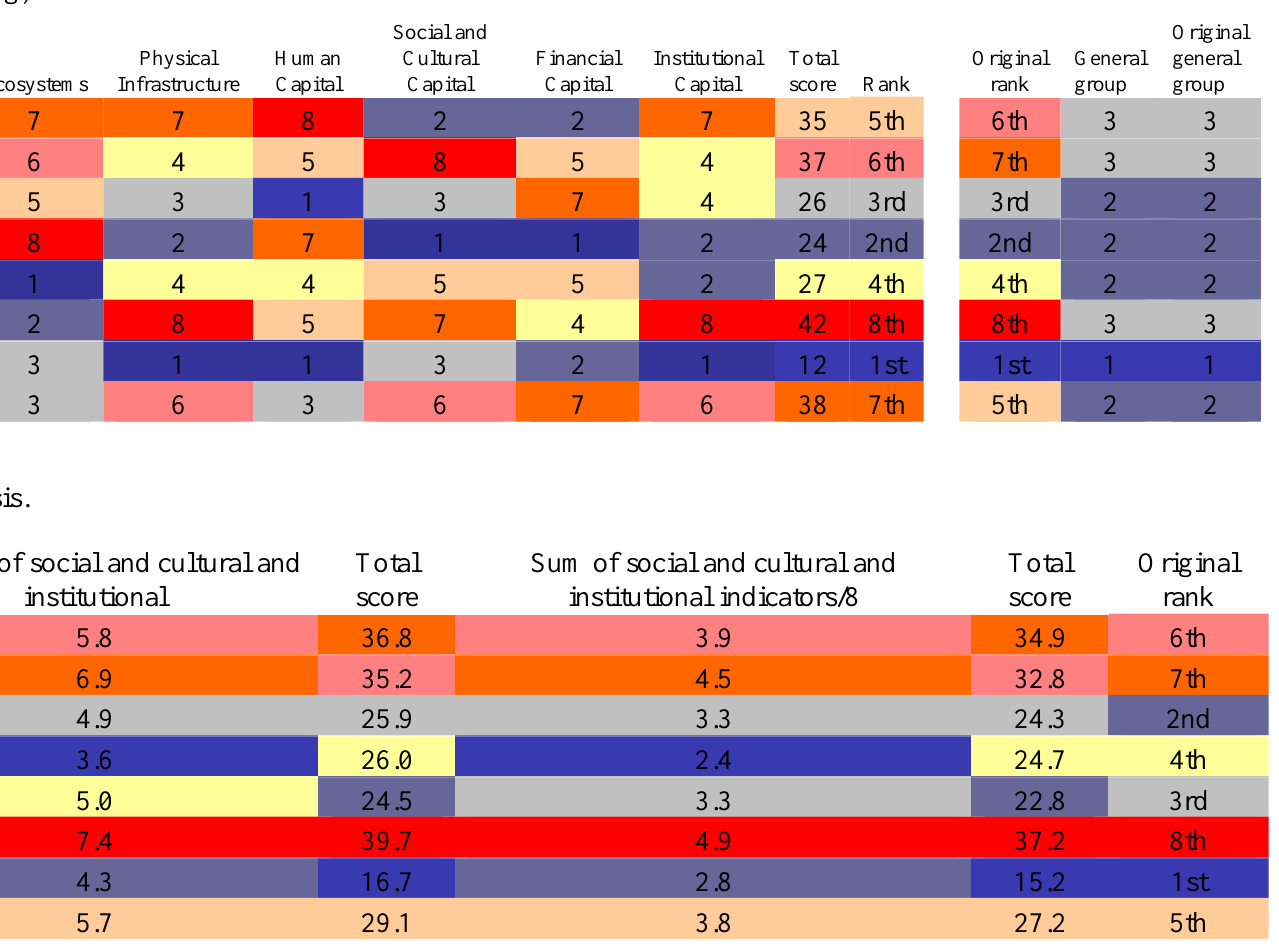
Table A3.3 Sensitivity framing, sum of domain ranks.